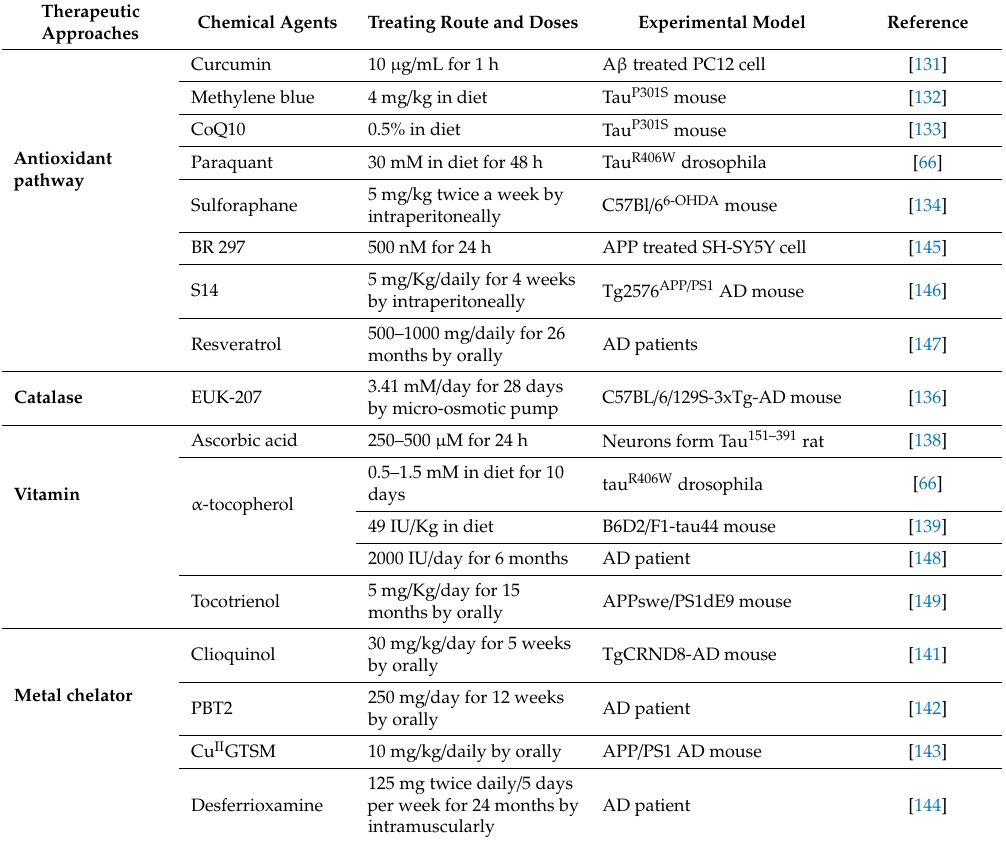
Table 3. Therapeutic approaches of tauopathies related to